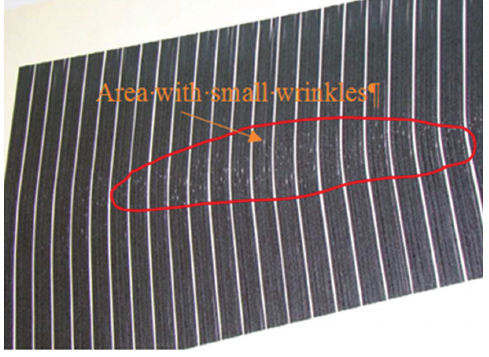
Figure 13 Fiber steering trial case 2: θ = 10 ° , ply 2, laid down at 2